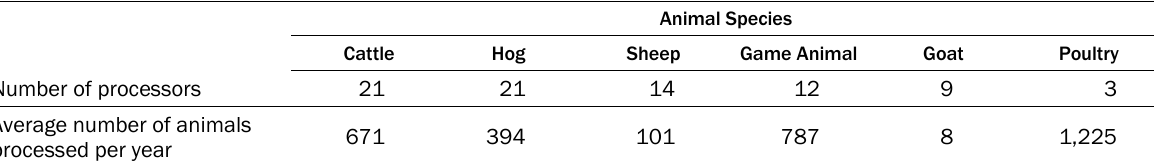
Table 3. Processors Processing Different